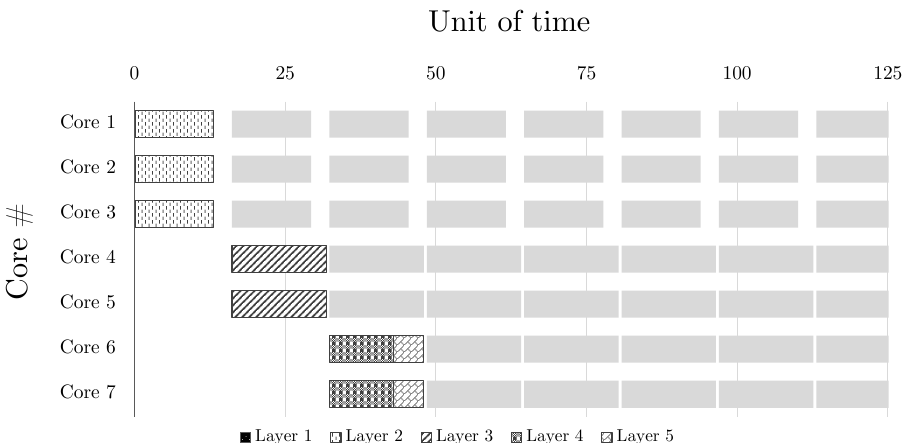
Figure 10. Example of redistribution of the workload over multiple cores (gray shadows show the potential execution of successive pipelined computations of the same application).